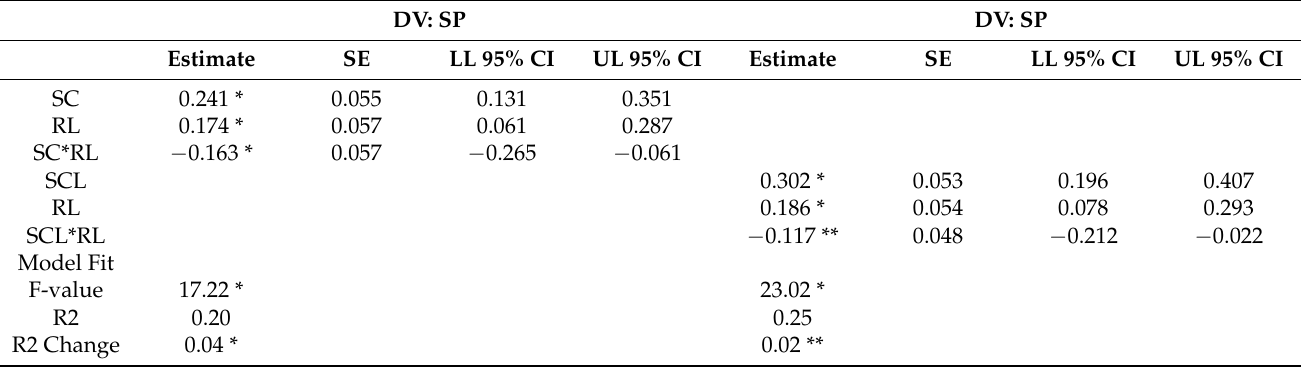
Table 5. Five thousand bootstrap results for PROCESS Model No. 1, simple moderation analysis.